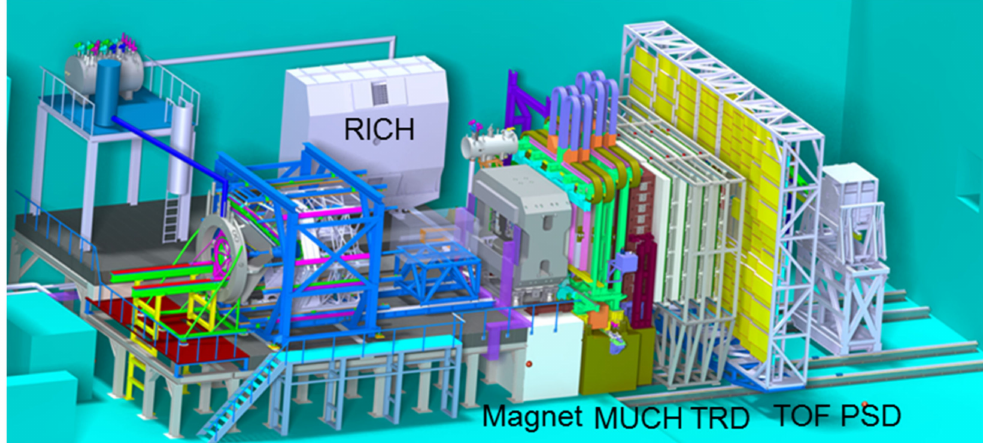
Figure 6. The CBM setup ( right ) and the HADES detector ( left ), which will be operated alternately, with the beam coming from left. The CBM micro-vertex detector (MVD) and the silicon tracking system (STS) are located inside the CBM magnet, followed by the muon detection system (MUCH), while the electron detector (RICH) is in parking position. Downstream of the MUCH, the transition radiation detector (TRD), the time-of-flight wall (TOF) and the projectile spectator detector (PSD) are located. The HADES beam dump in front of the CBM magnet will be removed for CBM